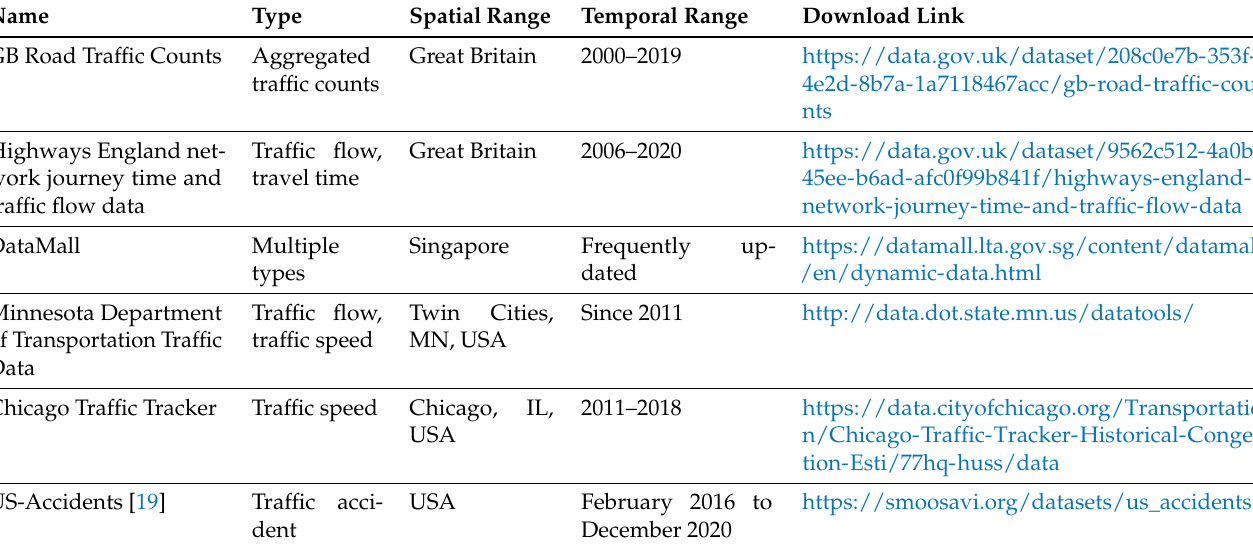
Table 1. The list of open survey